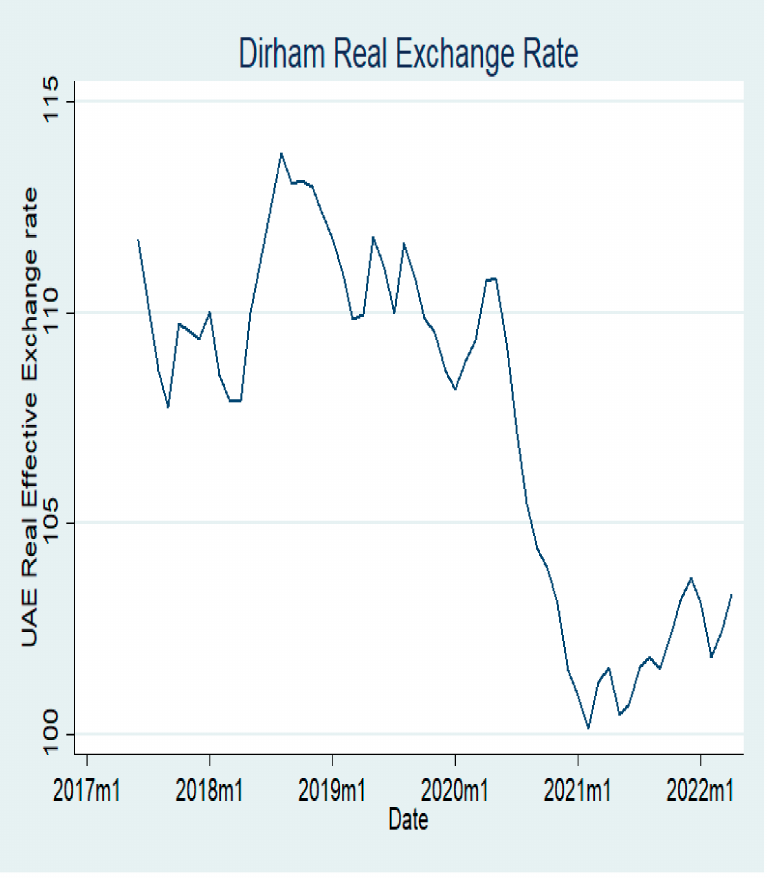
Figure 2. Dirham real exchange rate.